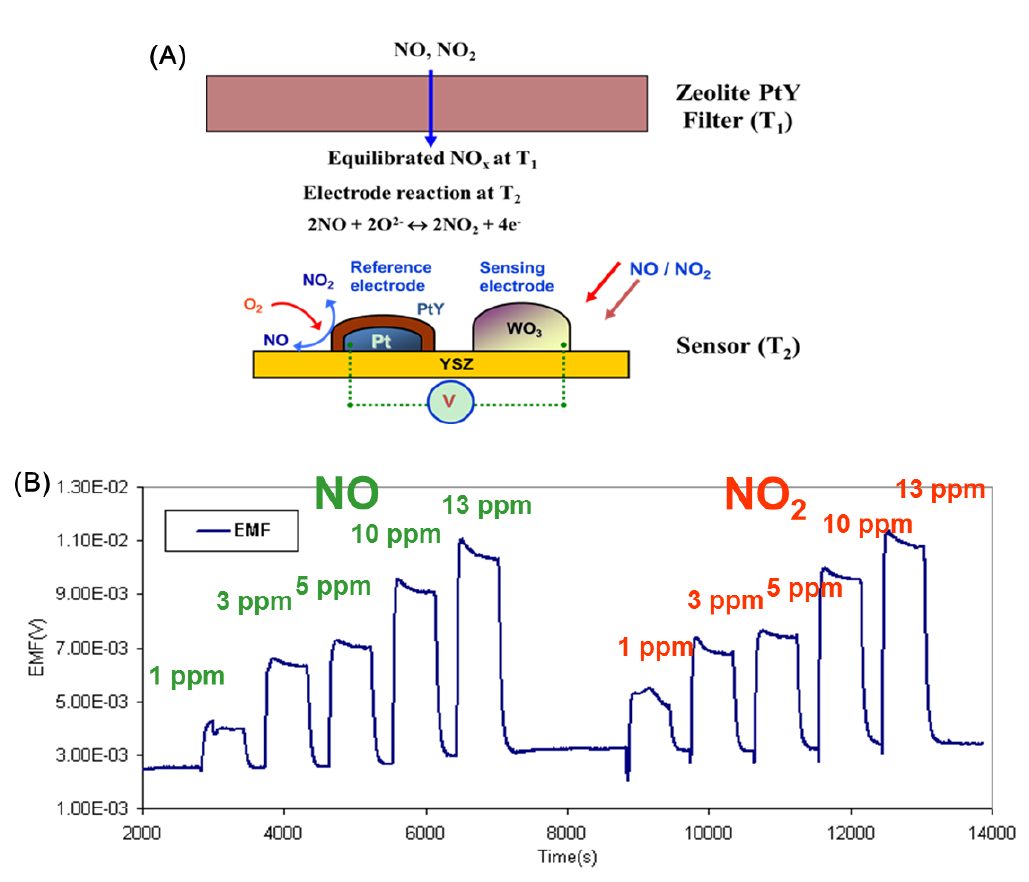
sensor, zeolite filter at 450 °C (T x ) electrode at 600 °C (T 3